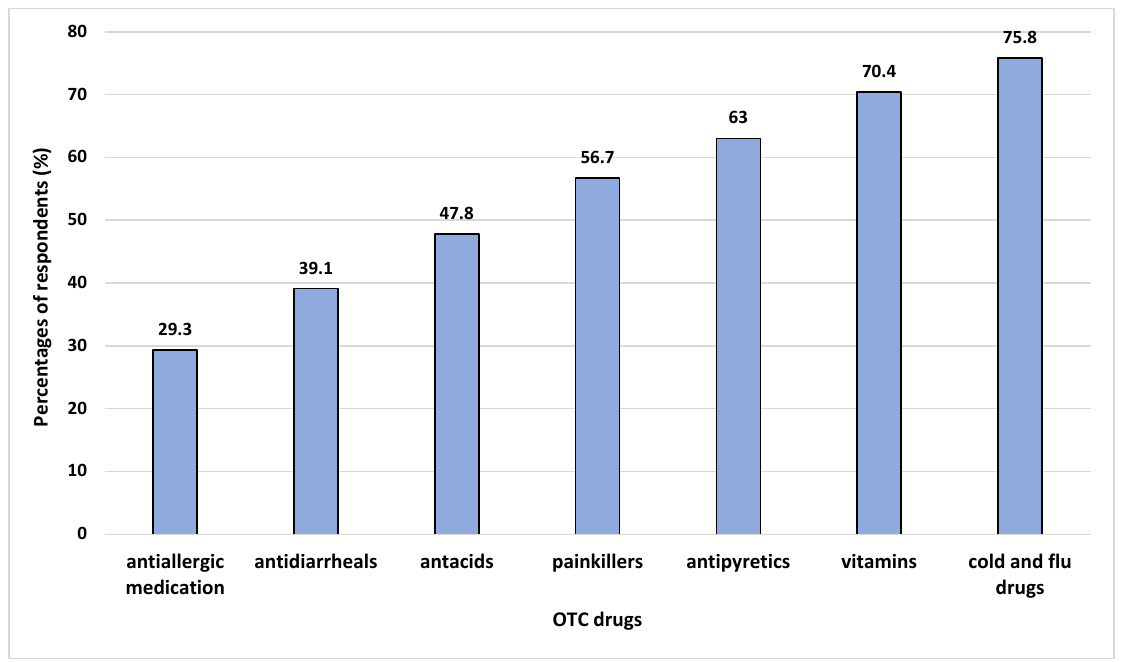
Figure 2. Respondents’ favoured OTC drugs. Table 5. Respondents’ actions on the use of OTC